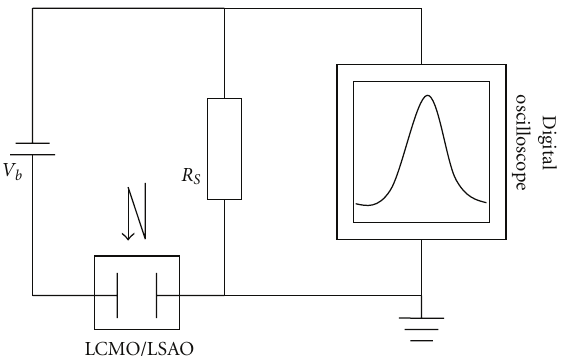
Figure 1: The schematic circuit of the sample measurement.